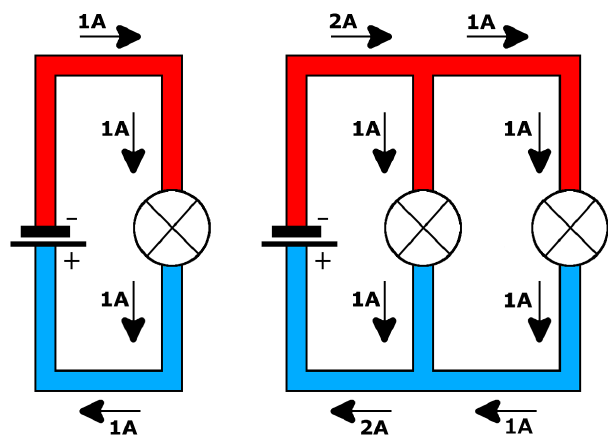
FIG. 10. In the case of an ideal battery, the electric pressure difference remains the same when a second light bulb is connected in parallel. Since the second bulb is identical to the first, the current leaving the battery doubles. The arrows refer to the direction of electron